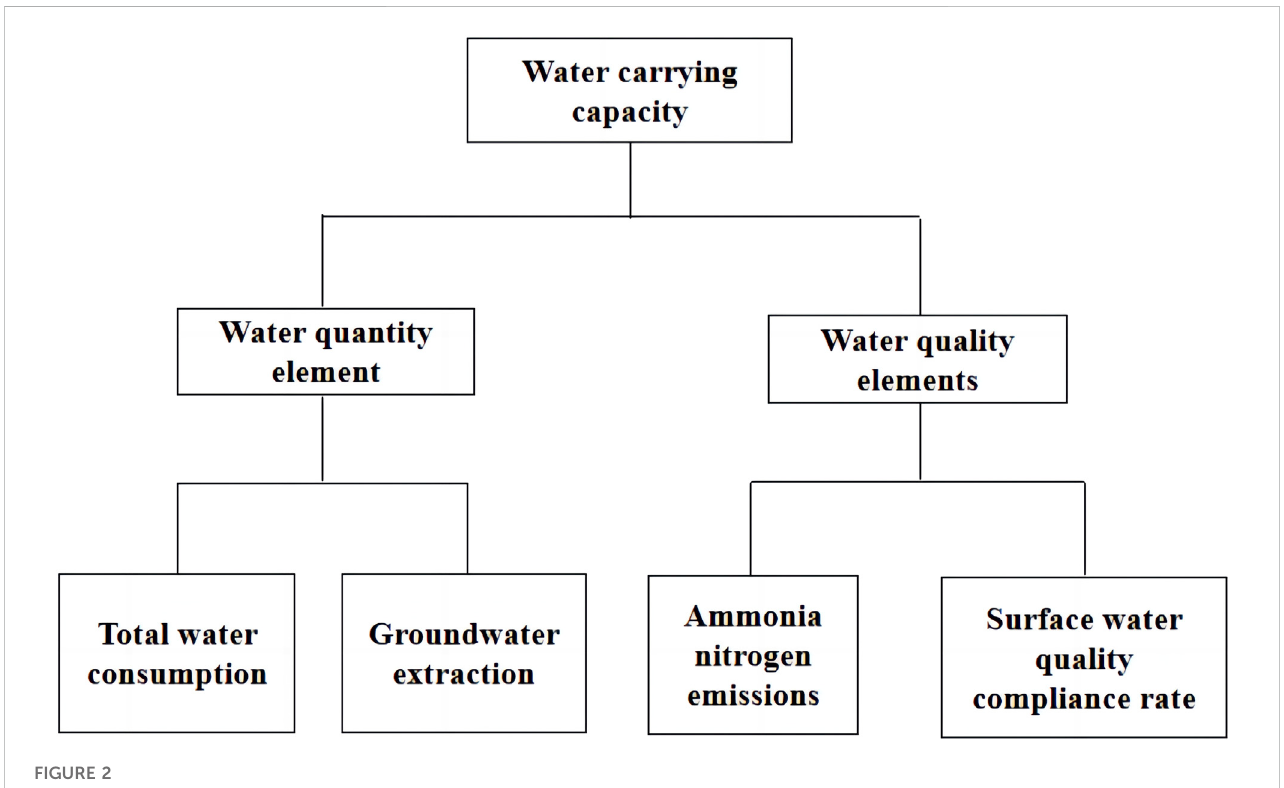
FIGURE 2 One-factor evaluation method index